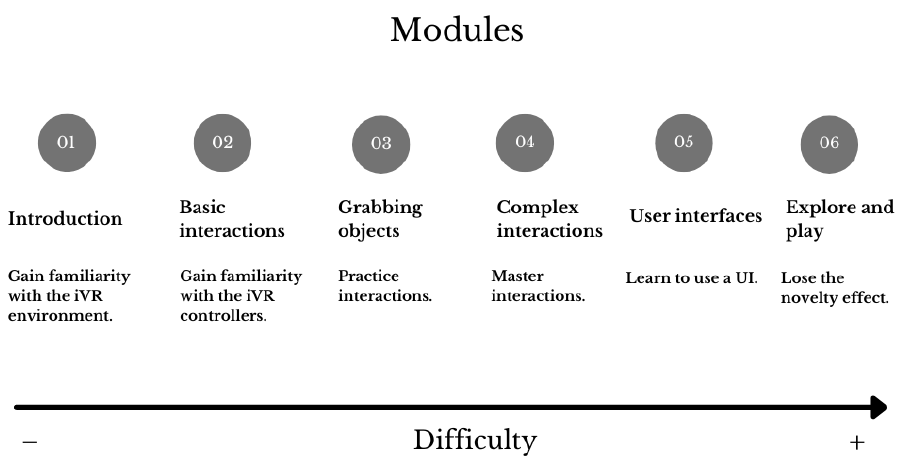
Figure 7. Tutorial modules and functions.